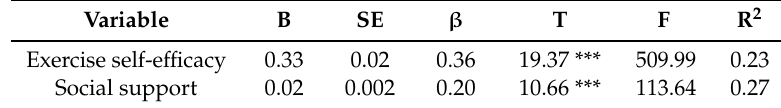
Table 3. Regression analysis on the predictors of the PA